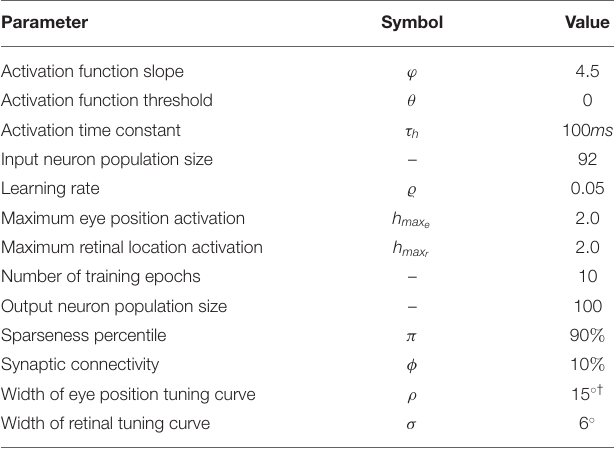
TABLE 2 | Simulation parameters of self-organizing